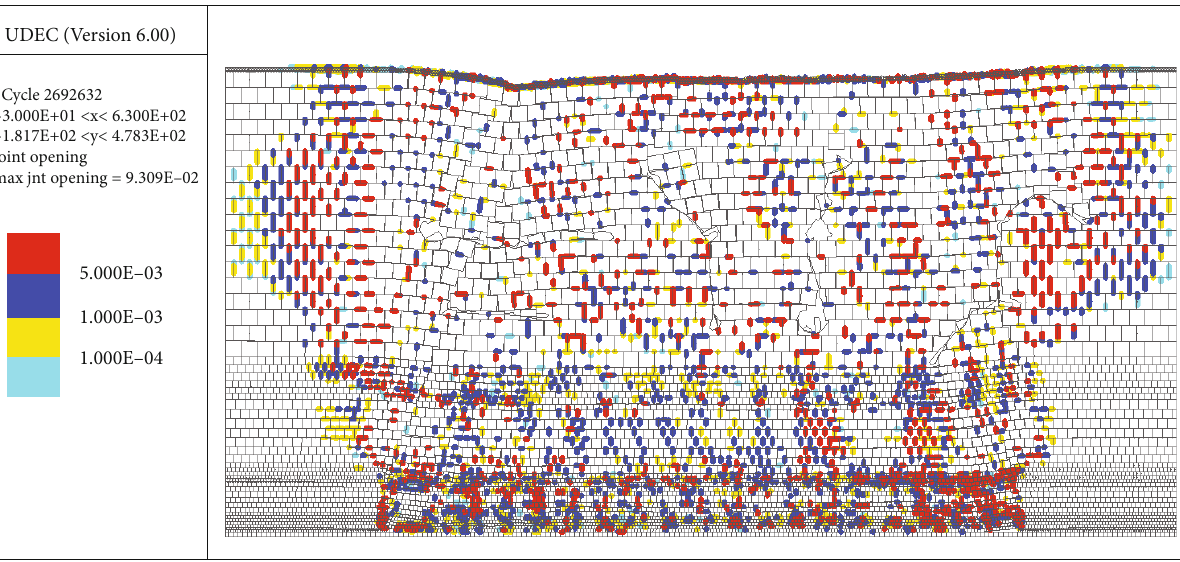
Figure 10: Mining-induced fracture fi eld (mining distance is 500 m in 9# coal